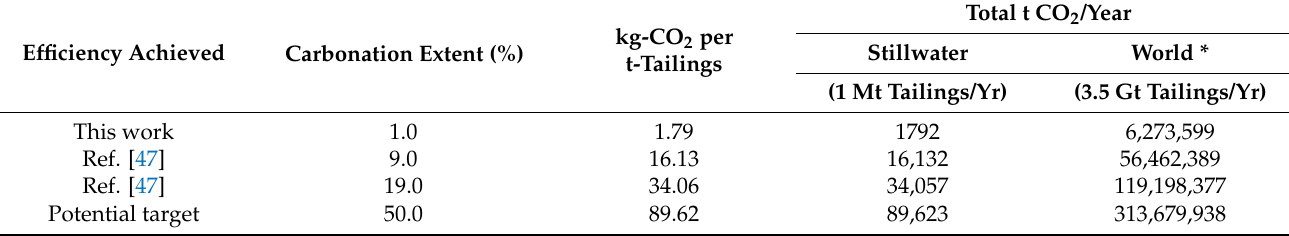
Table 10. CO 2 storage potential for mineralization of PGM